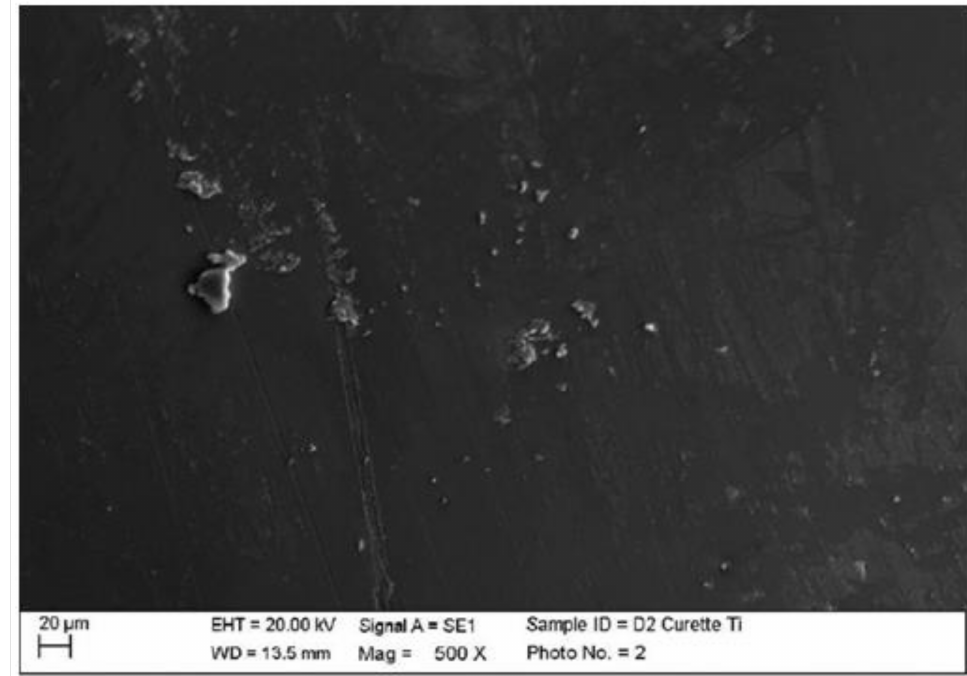
Figure 13. Instrumented disilicate sample D2 with titanium curette (500 × ). 3.